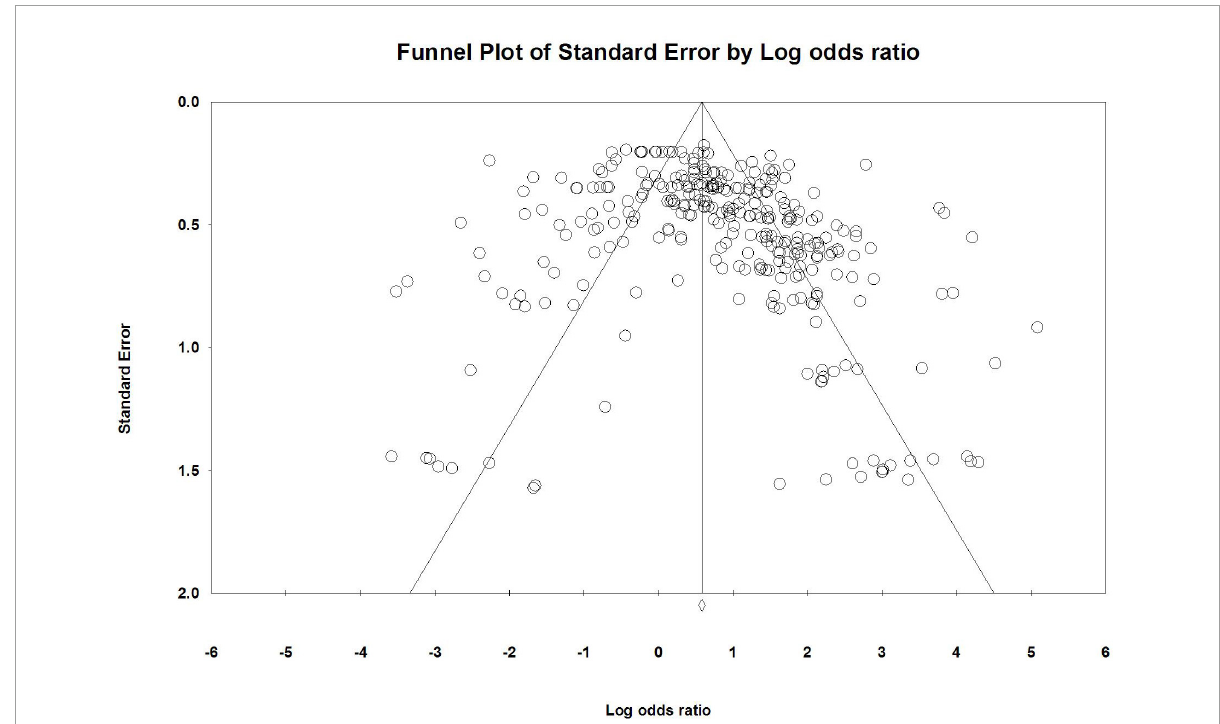
FIGURE2 Funnel plot for the study of the relationship between drawing characteristics and mental